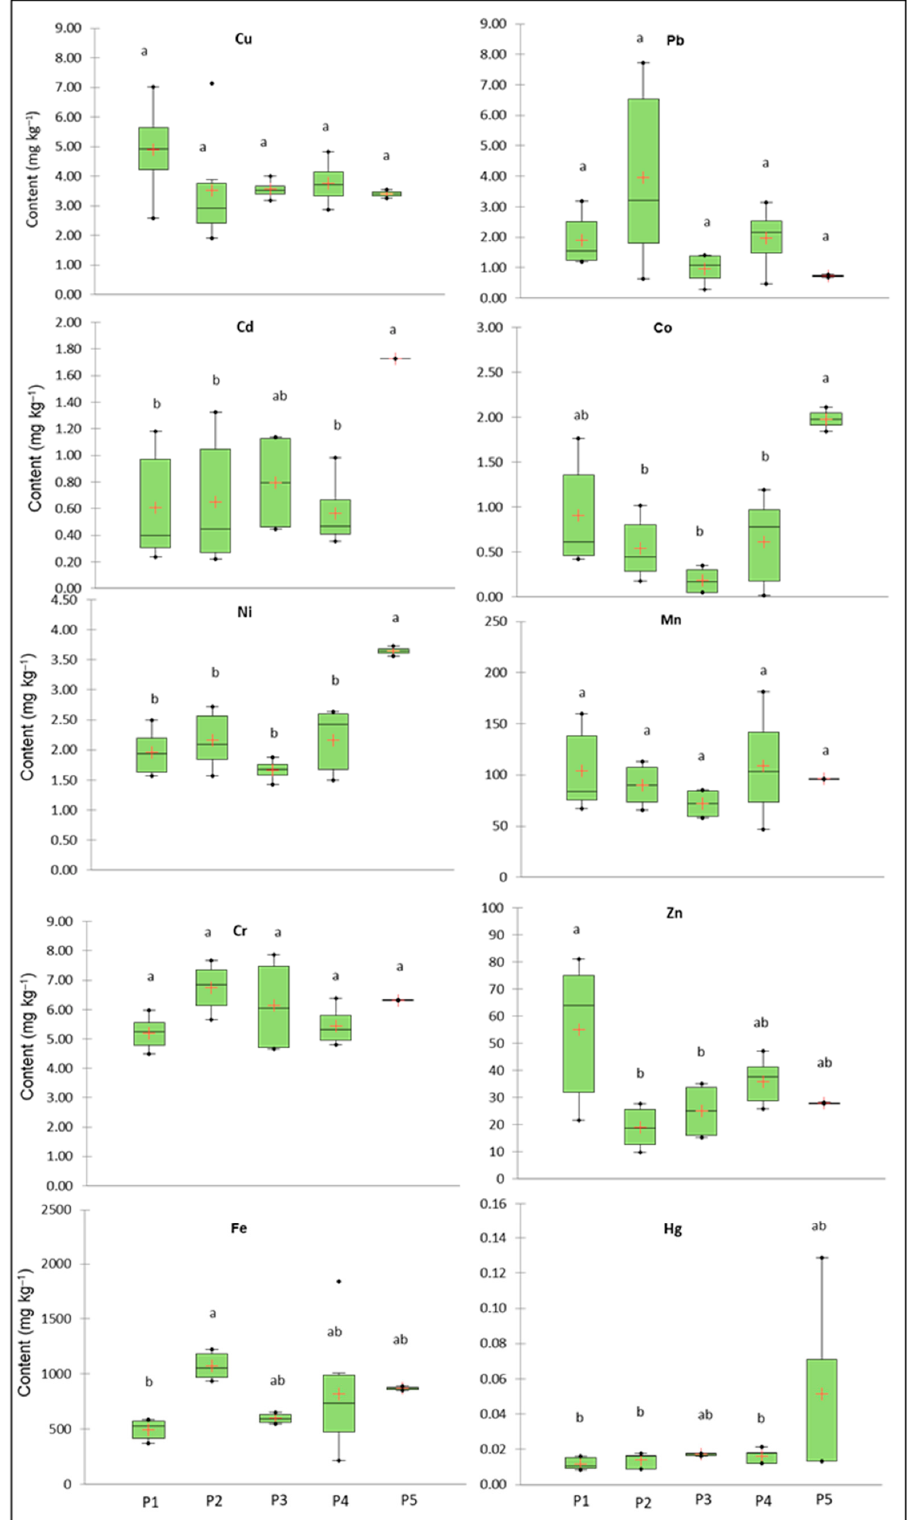
Figure 3. Content of elements in macrophytes growing in different plots of Lake Bohinj. Different le tt ers indicate statistical di ff erences between plots (ANOVA with the Tukey post hoc test, p < 0.05).